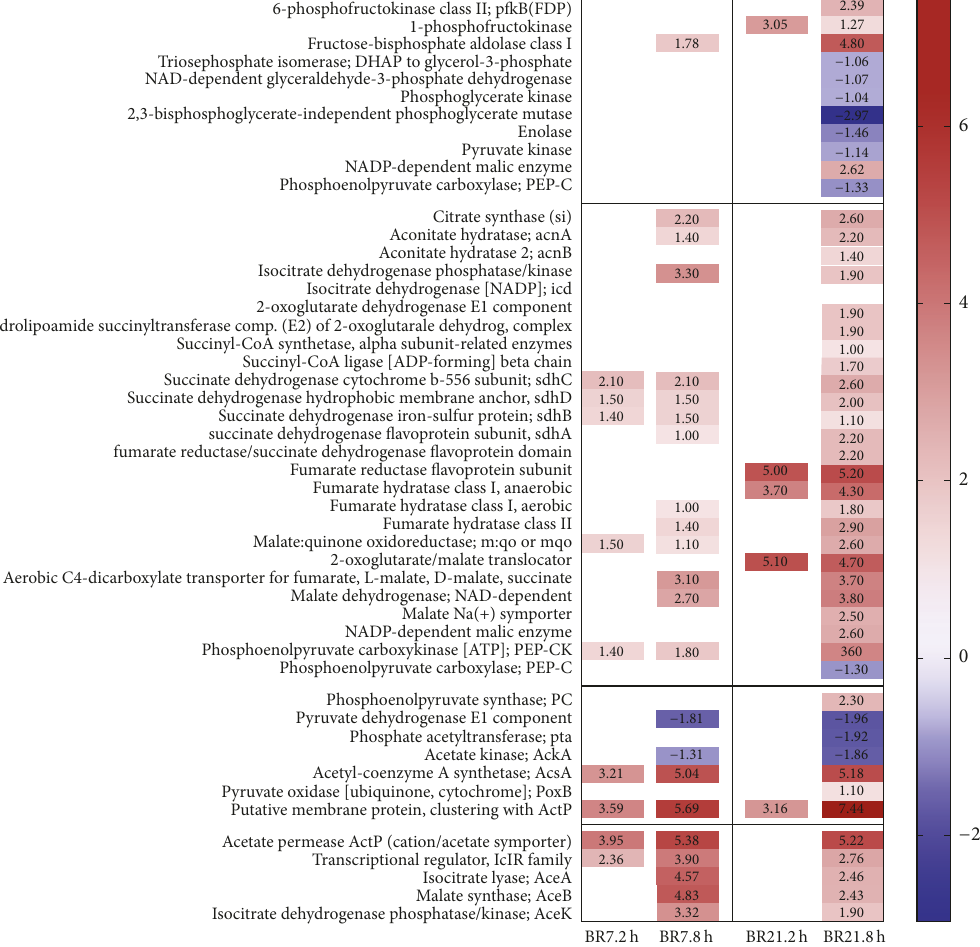
Figure 4: Transcriptional changes in glycolytic pathway: upper glycolysis (section 1, lines 1–11), lower glycolysis: pyruvate and acetate (section 3, lines 38–44), the tricarboxylic acid (TCA) pathway (section 2, lines 12–37), and the glyoxylate shunt (section 4, lines 45–48) after lethal imipenem exposure . At 8 h of imipenem exposure, both BR7 and BR21 strains exhibit a similar metabolic transcriptional profile. Illustrations to guide the reader through these pathways are provided in cited research [32, 33]. Color scale shows gene expression of log 2 fold change (FC) from low (blue) to high (red) expression in imipenem-exposed compared to unexposed bacterial populations (three biological replicates in each sample group). A false discovery rate 𝑝 value correction (FDR) ≤ 0.05 was